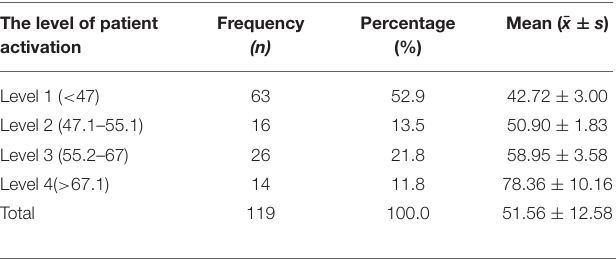
TABLE 2 | The patient activation level in patients with stroke ( n = 119).